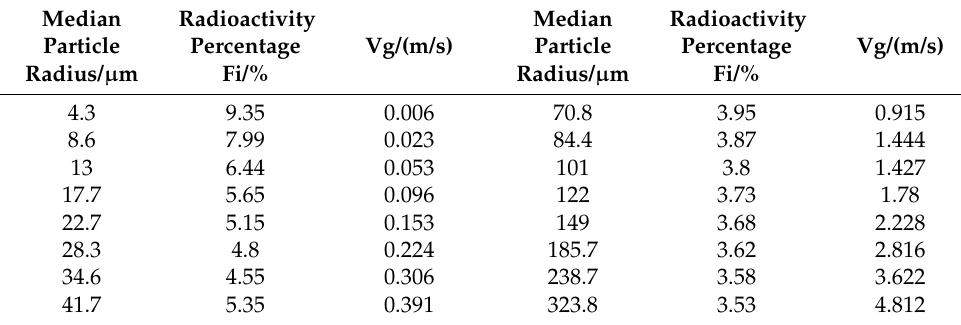
Table 1. Percentage of total radioactivity and gravitational settling velocity in the radius of the median particle of the ground